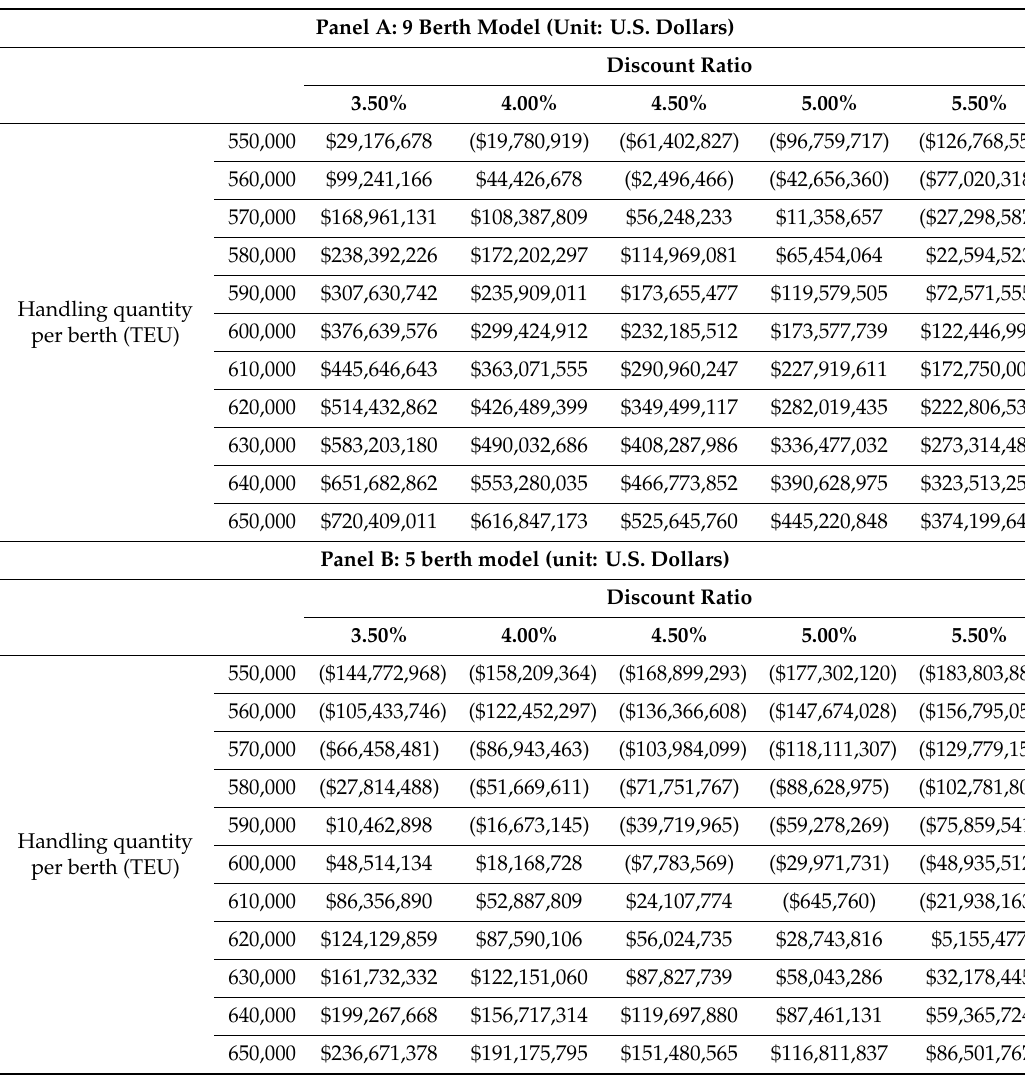
Table 11. NPV per berth considering changes of processing quantity and discount ratio. Panel A: 9 Berth Model (Unit: U.S.